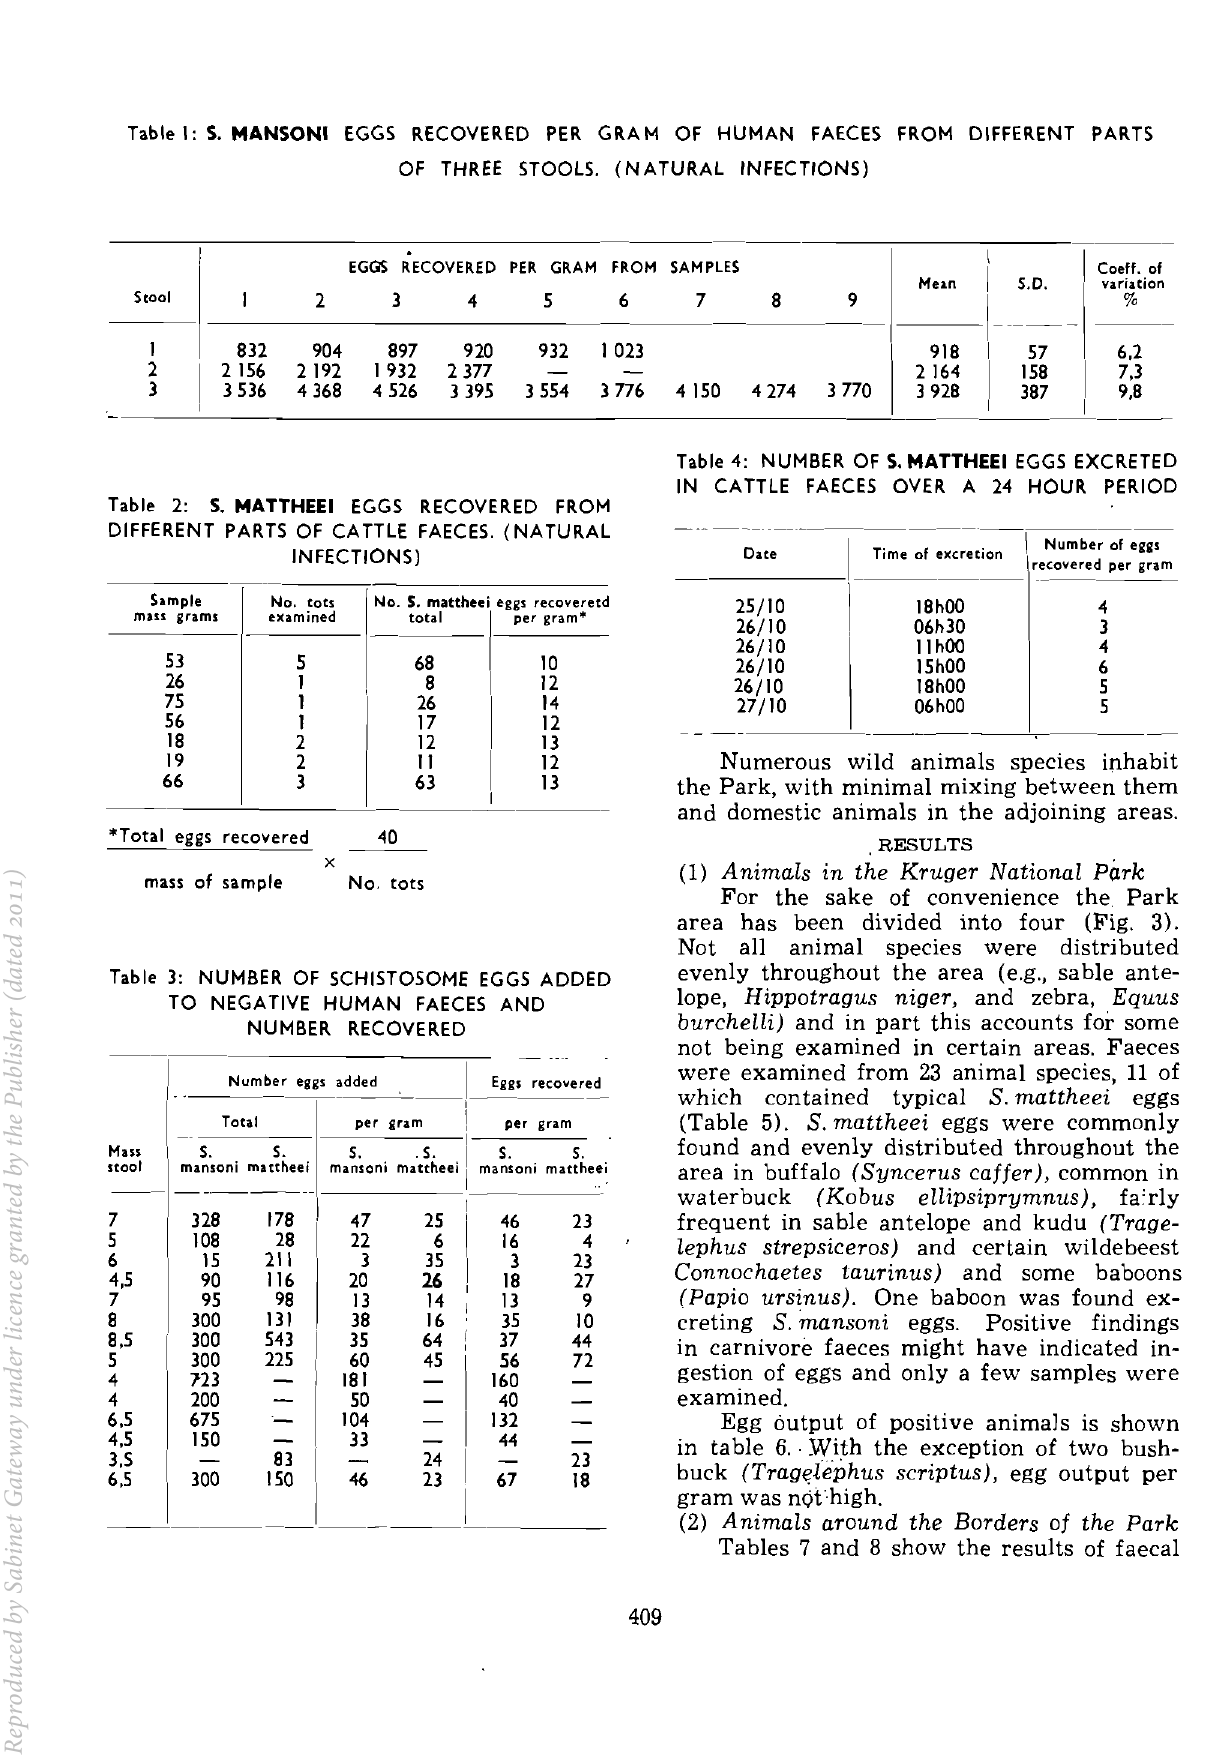
I EGGS RECOVERED PER GRAM FROM